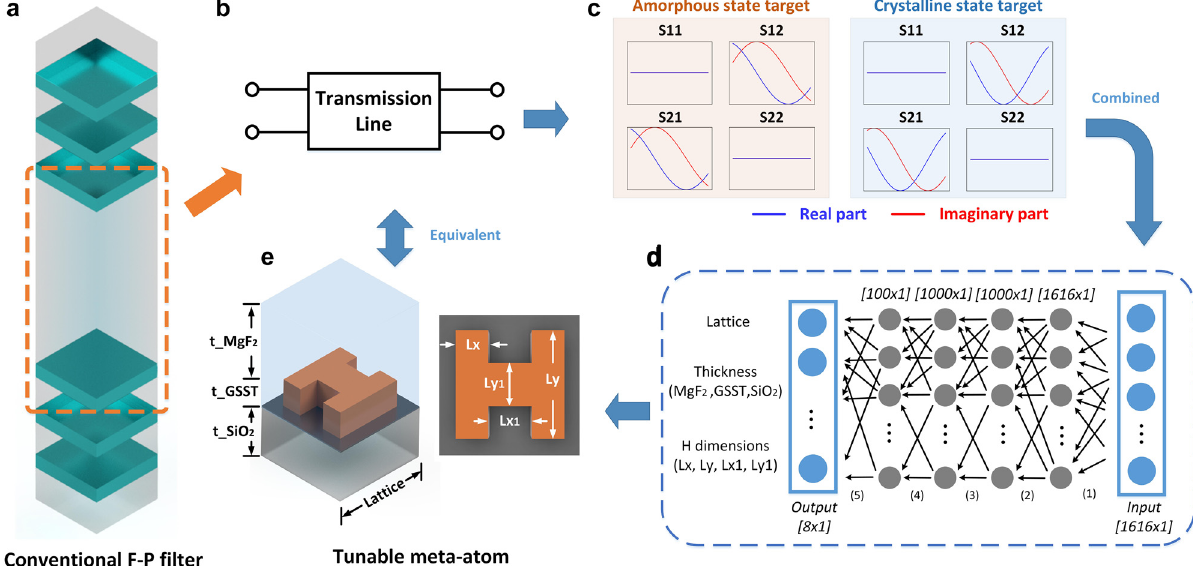
Figure 4: Inverse design DNN. (a) A conventional F–P bandpass filter with two DBRs separated by a cavity. (b) The spacing (cavity) between two DBRs was treated as a two-port transmission line. (c) S -matrices of the transmission lines were designated as input of the inverse DNN. (d) The meta-atom inverse DNN constructed based on fully-connected neural networks. (e) Output of the inverse DNN, which is a combination of design parameters including all meta-atom